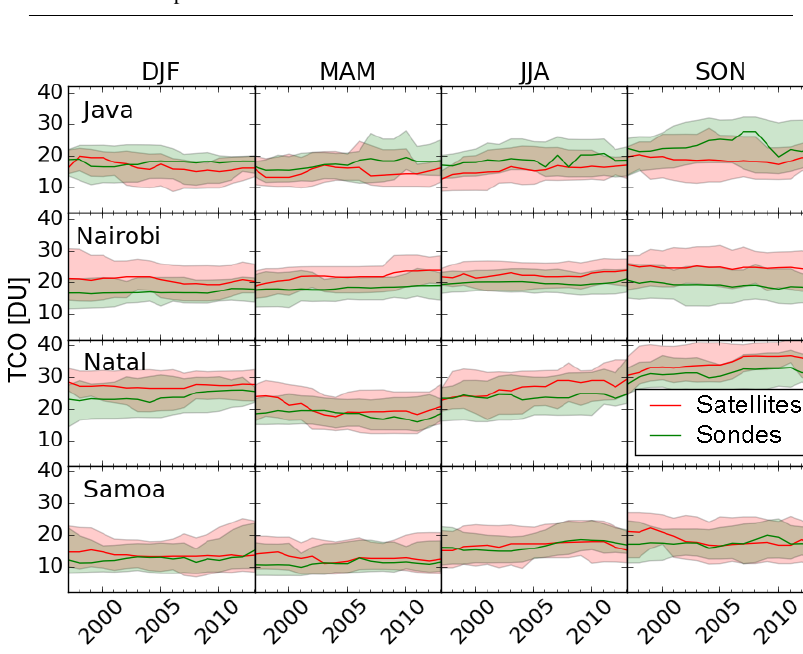
Figure 5. Average TCO for seasonal 5-year sampling. On the x axis the interval 1995 to 2000 is shown as 1997. The shaded area illustrates the 10th to 90th percentile interval. For most cases the satellite data (red) and sonde data (green) agree within this range.